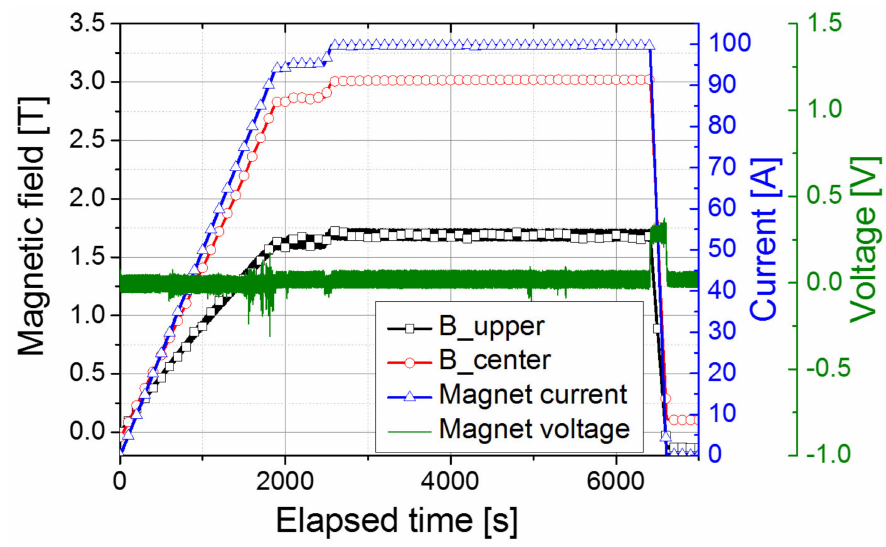
Figure 8. Center and upper part magnetic field, magnet current and voltage of the first charging test.